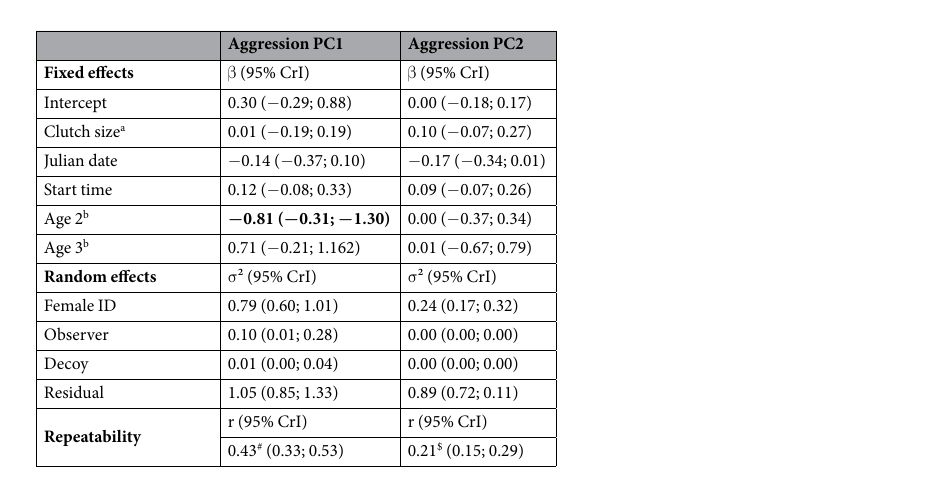
Descriptive statistics of separate aggression parameters are given in Supplementary Table S1. The PCA of the aggression parameters produced two principal components with eigen- values > 1, together explaining 65% of the total variance (Table 1). Higher scores on the first component (PC1; explaining 43% of the variance) reflected closer approach distance, more time on the decoy, more attacks, and a higher likelihood to enter the nest box. On the other hand, low scores on PC1 reflected more alarm calls produced at larger distances from the decoy. The second component (PC2) explained 22% of the variance and reflected a contrast between entering the nest box (low scores) and the other aggression parameters (high scores). Sources of variation in aggression PCs.